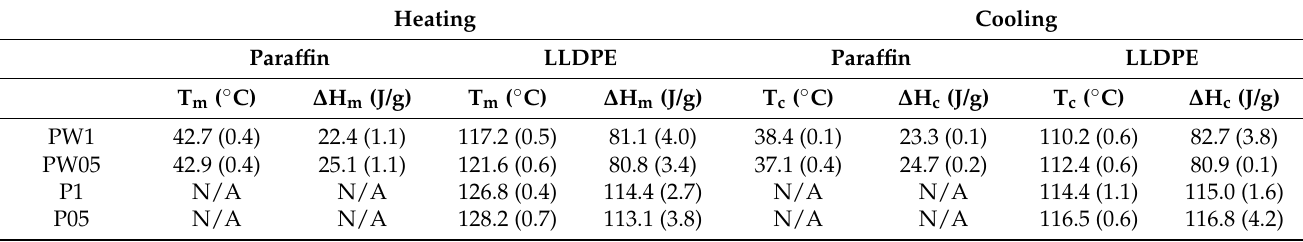
Table 5. DSC characterization of foams. The standard deviations are shown in brackets.